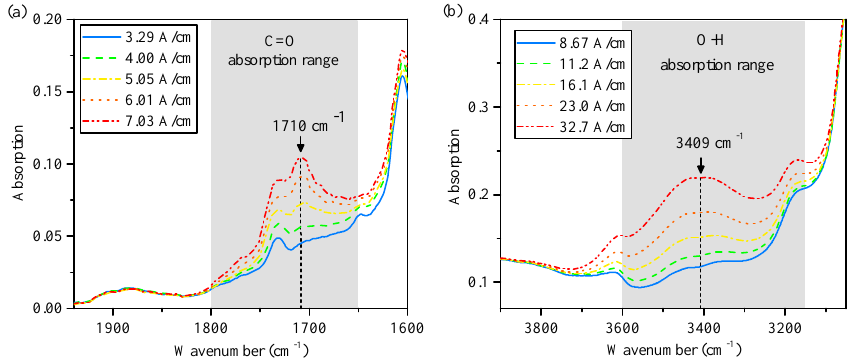
Figure 1. ( a ) Section of the infrared absorption spectrum of a wind turbine gearbox oil with different oxidation levels ranging from 3.29A/cm to 7.03A/cm according to ASTM E2412; ( b ) Section of the infrared absorption spectrum of an automotive gearbox oil contaminated with different concentrations of water ranging from 0ppm to 1991ppm, corresponding to ASTM E2412 readings of 8.67A/cm to 32.7A/cm.